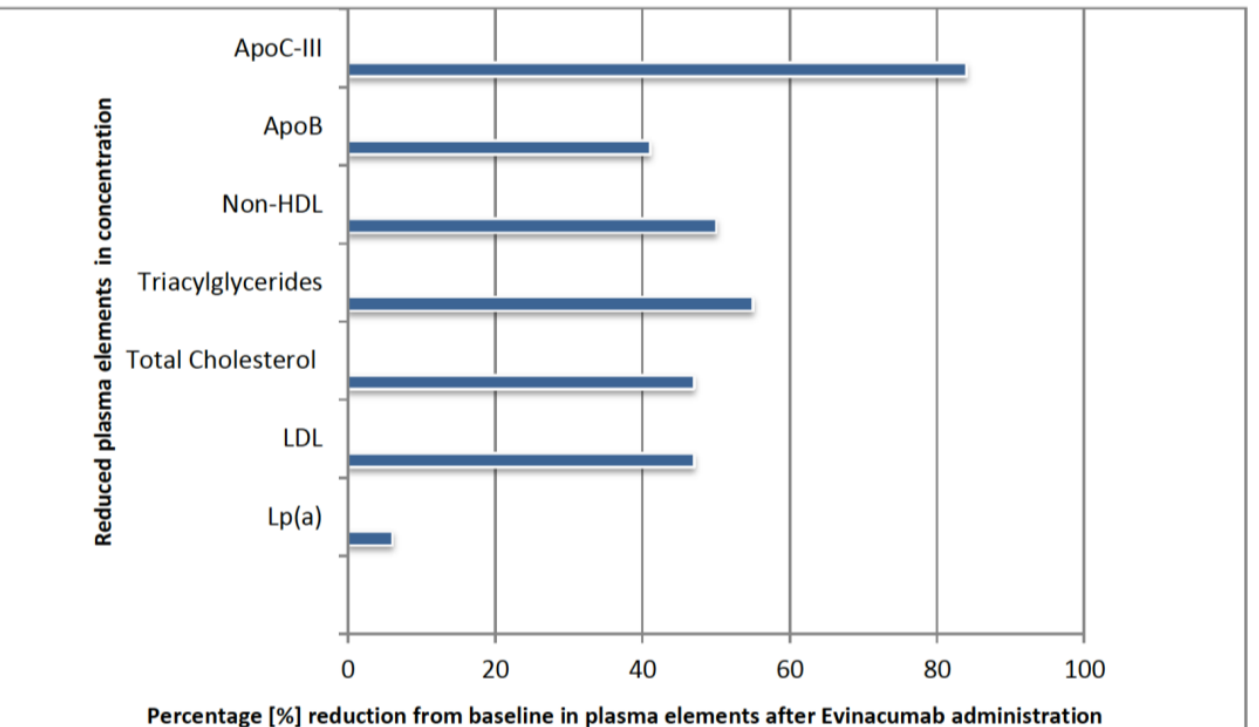
Figure 4. Changes in Plasma Components Affected by Evinacumab after 24 Weeks [16]. ApoC-III, Apolipoprotein C-III; Lp(a), Lipoprotein(a).